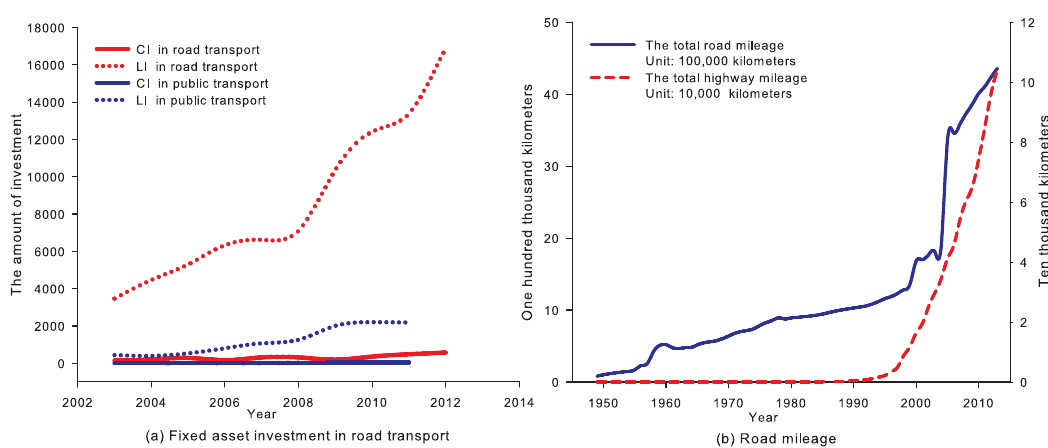
Figure 1. Fixed asset investment in road transport and road mileage in China (CI and LI stand for investment from the central government and local governments respectively; data source: NBSC, http://data.stats.gov.cn/index).